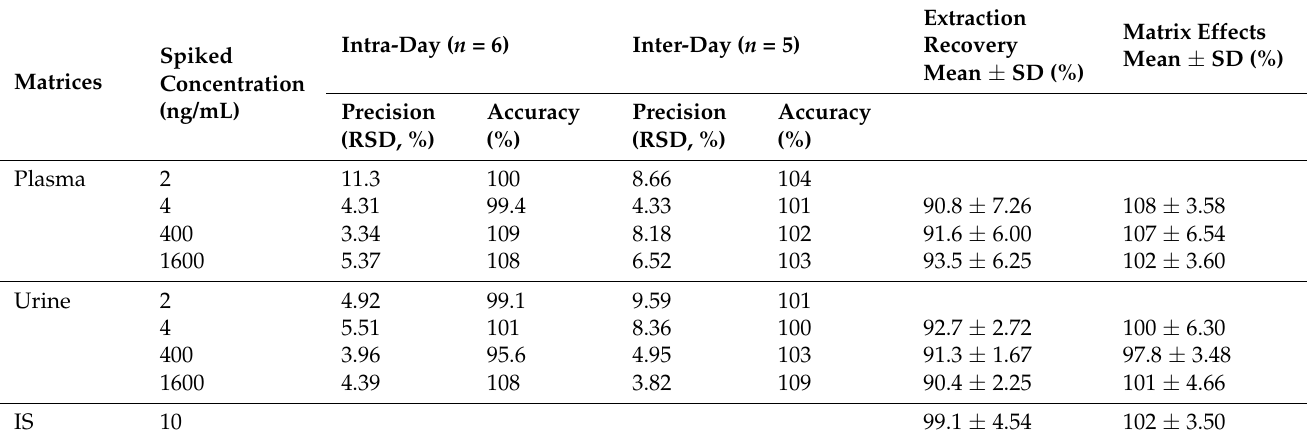
Figure 3. Representative chromatograms of BIT ( I ) and phenacetin (IS) ( II ) in six rat homogenates (lung, spleen, liver, kidney, heart, and brain): ( a ) double blank tissue homogenates; ( b ) blank tissue homogenates spiked with BIT at the LLOQ (10 ng/mL) and the IS; ( c ) real samples for lung and spleen from 180 min after intravenous administration of 10 mg/kg BIT and real samples for liver and kidney from 30 min after intravenous administration of 10 mg/kg BIT. ND, not detected. Table 1. Intra- and inter-day accuracy, precision, extraction recovery, and matrix effects of BIT in rat plasma and